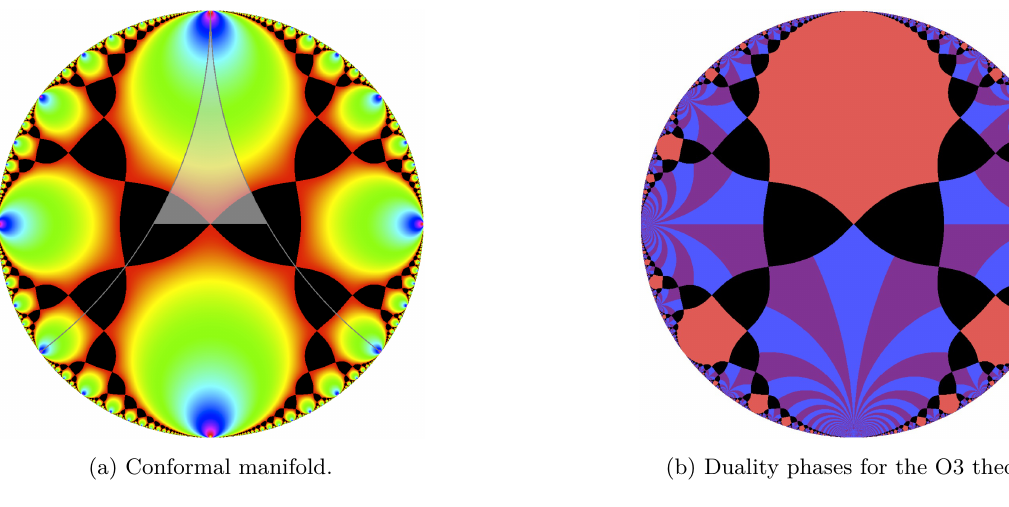
Figure 2. a The upper half place, conformally mapped to a disk. We have lightly shaded a copy of the fundamental region for SL(2 , Z ) . Every other point in the disk can be mapped to this region by a SL(2 , Z ) transformation. The blue/purple regions correspond to regions where weakly coupled descriptions exist in some duality frame. b Partition of the conformal manifold of the N = 4 so (2 N + 1) theory into regions where at weak coupling the valid description is in terms of a so (2 N + 1) algebra (pink) or usp (2 N ) (blue/purple). [Figures reproduced from